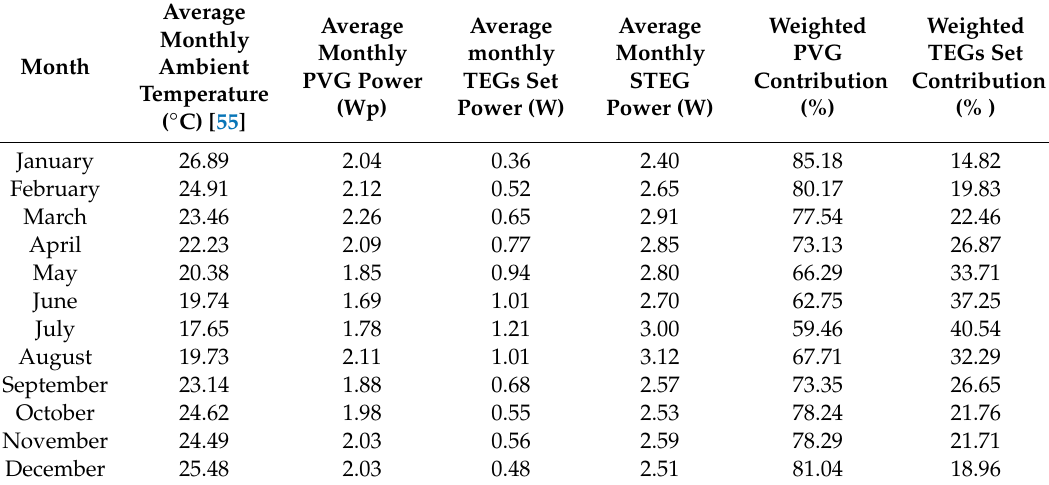
Figure 12. Weighted average monthly power contribution. Table 4. Average monthly power by technology and weighted contribution.